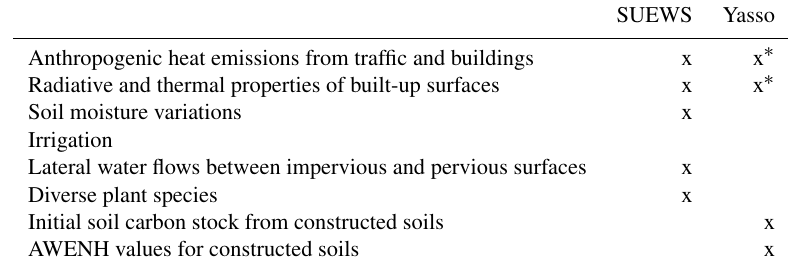
Table B1. Urban-specific processes accounted for in SUEWS and Yasso. Anthropogenic heat emissions from traffic and buildings x x ∗ Radiative and thermal properties of built-up surfaces x x ∗ Soil moisture variations x Irrigation Lateral water flows between impervious and pervious surfaces x Diverse plant species x Initial soil carbon stock from constructed soils x AWENH values for constructed soils